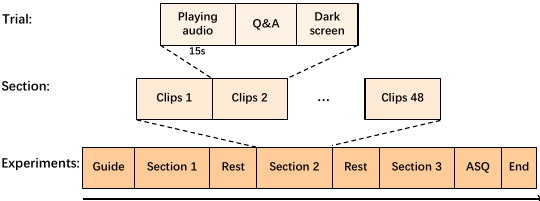
Figure 3. The experimental procedure consisted of three sections and two rests. In each session, 48 stimuli clips were played